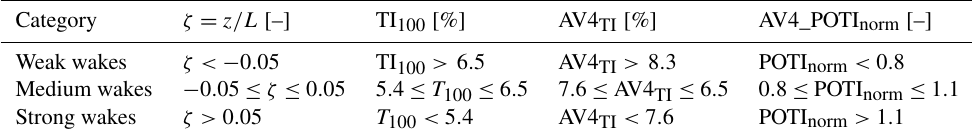
Figure 9. Wake effects in alpha ventus (AV) under different atmospheric conditions classified by ζ = 33 /L . Power of downstream turbine normalised with free-flow turbine. Upper row: single wake, bottom row: double wake. Left column: Normalised Power as a function of wind direction, right column: Normalised power as a function of wind speed. Table 2. Summary of thresholds for the different classes of interest at alpha